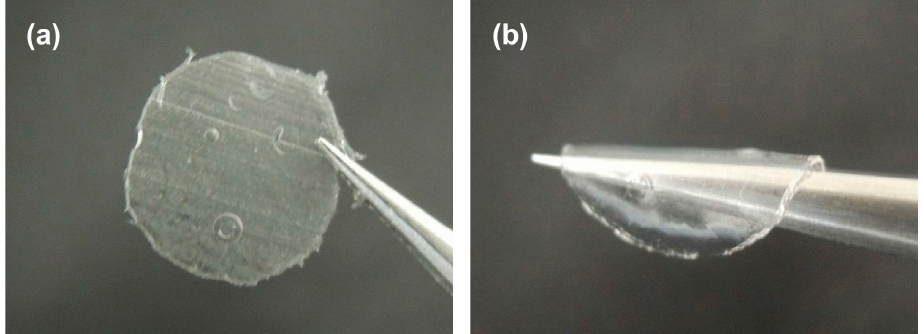
Figure 8. The sheet-shaped PEG-grafted chitosan hydrogel: ( a ) dried sheet-shaped gel; ( b ) flexible sheet-shaped gel after immersion in water.